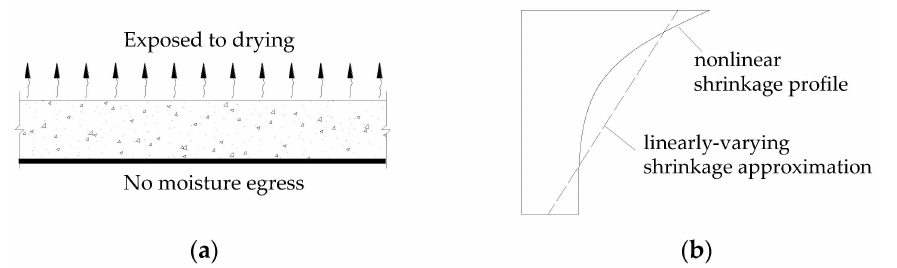
Figure 2. Typical exposure conditions of composite steel–concrete slab and qualitative representations of the shrinkage profiles: ( a ) exposure drying conditions, ( b ) shrinkage